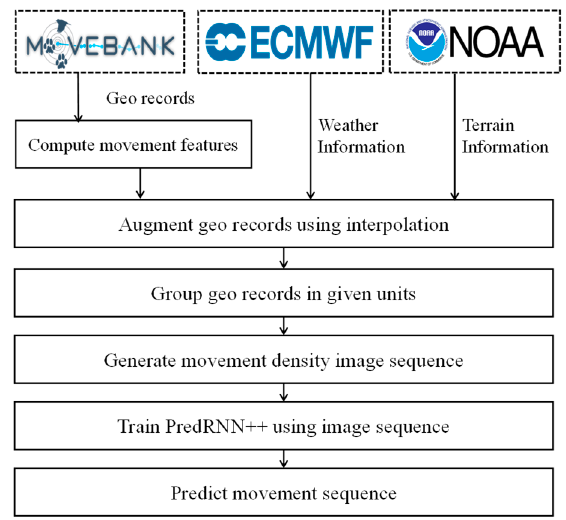
Figure 1. Overall flow of animal movement prediction.